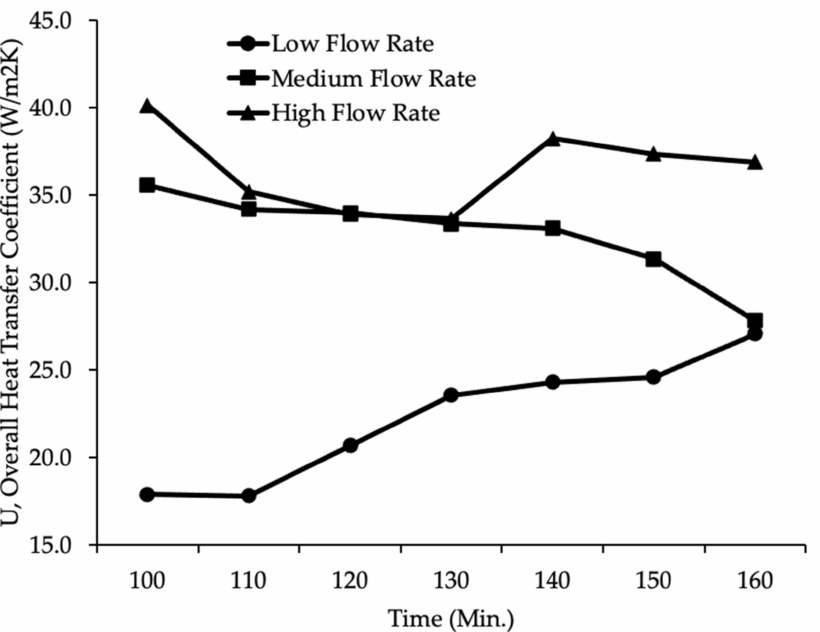
Figure 7. Overall heat transfer coefficients under various water flow rates on the tube